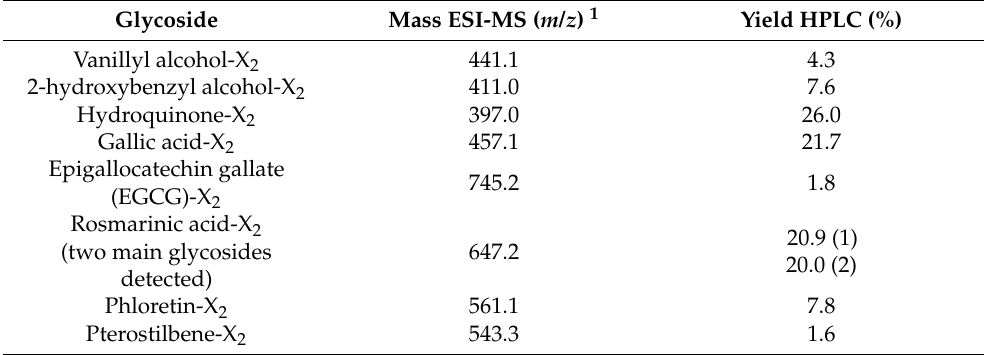
Table 3. Synthesis of glycosides by the glycosynthase variant rXynSOS-E236G using 20 mM X 2 F as xylobiose donor and different acceptor molecules at 20 mM. Glycosides were detected by ESI-MS in the positive mode as Na-adducts. The yield of the main glycoside of each reaction was calculated by